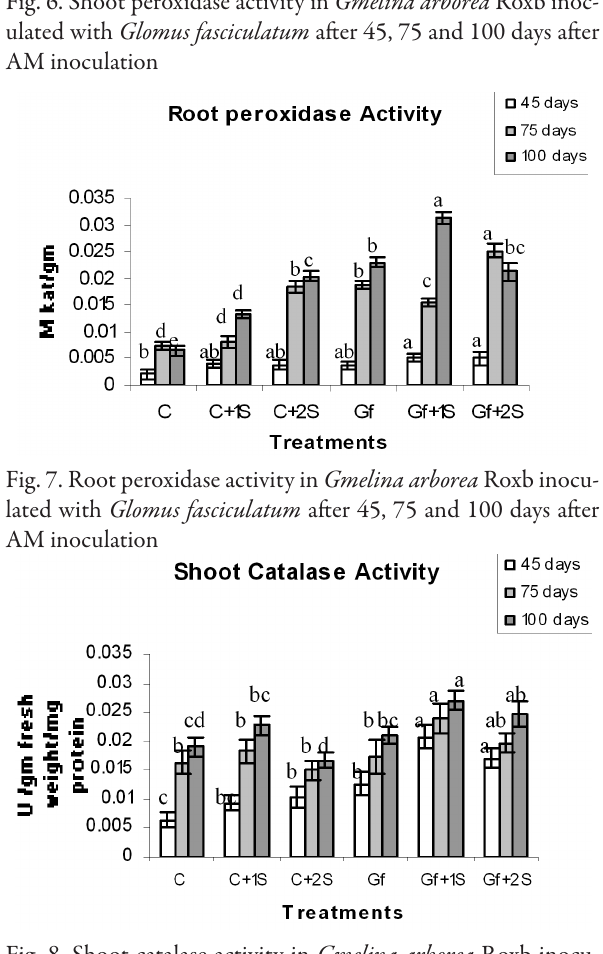
Fig. 8. Shoot catalase activity in Gmelina arborea Roxb inocu- lated with Glomus fasciculatum after 45, 75 and 100 days after